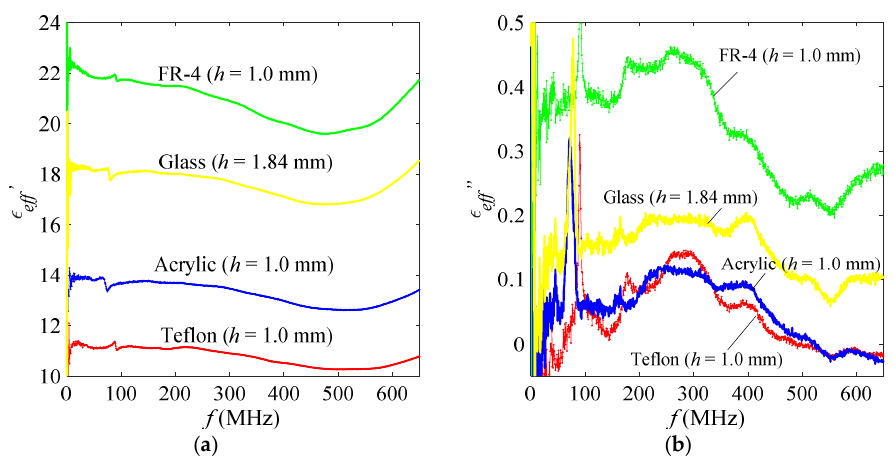
Figure 11. Comparison of ( a ) real part, R e ( Ỹ BB′_MUT ), and ( b ) imaginary part, I m ( Ỹ BB′_MUT ), of the normalized admittance at probe aperture for four MUTs.